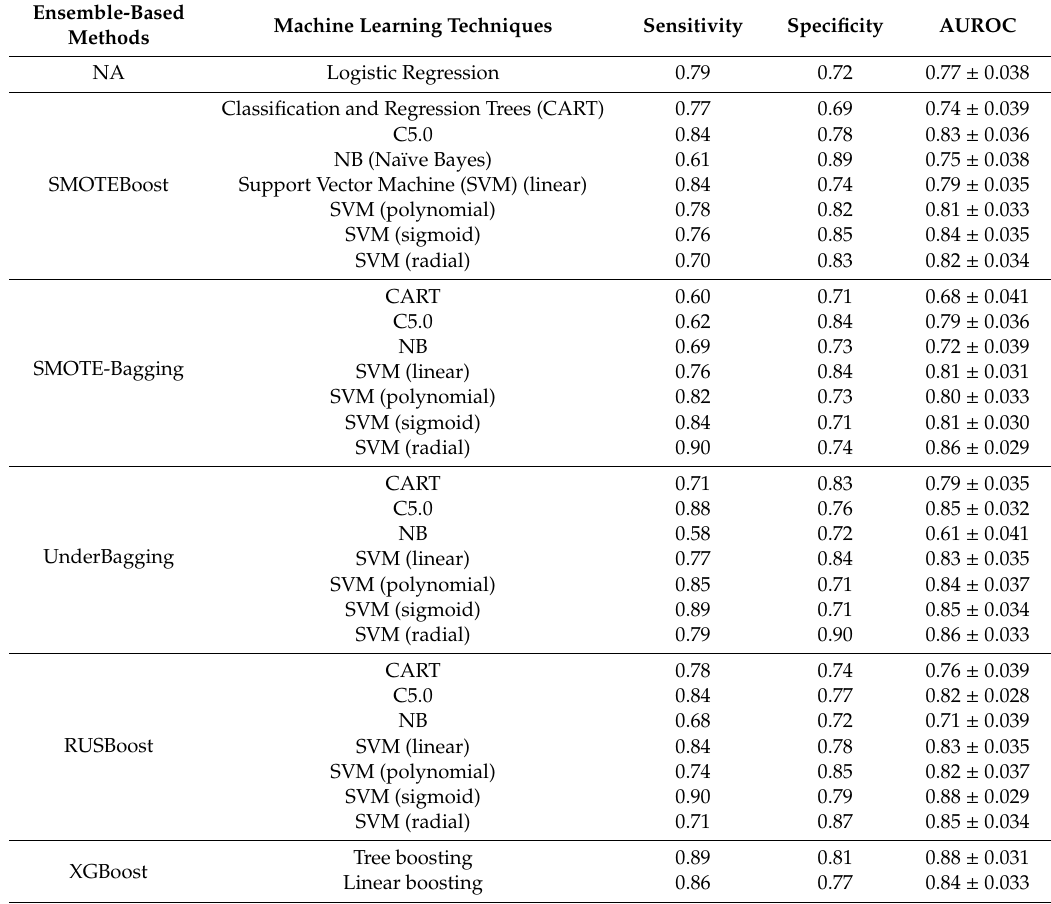
Table 2. Performances of the machine learning techniques grouped by four ensemble-based methods and results of cost-sensitive regression analysis. The table contains sensitivity, specificity and AUROC of the cross-validation AUC of all the prediction